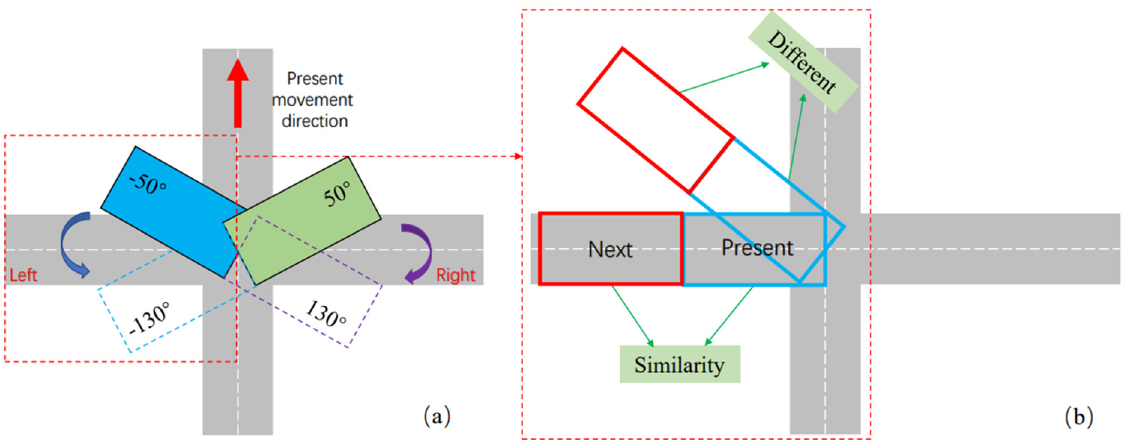
Figure 5. The window is rotated to search for the road direction and whether the road is a one-sided or bilateral intersection. ( a ) The range of search angles for sliding the window and ( b ) the calculation of image homogeneity to determine the direction.